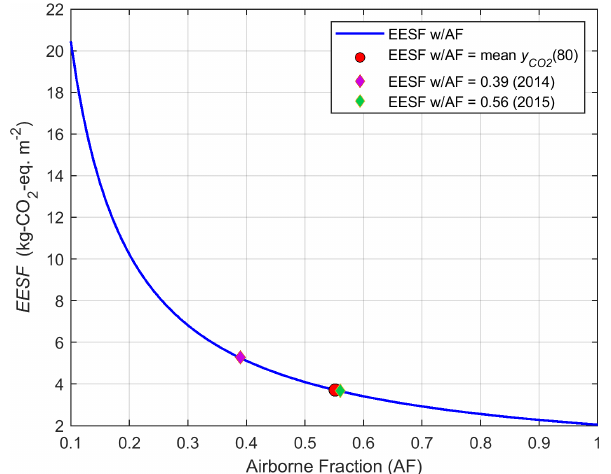
Figure 5. Sensitivity of EESF to the airborne fraction